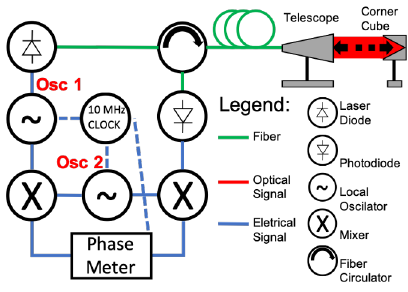
Figure 3. Sensor scheme with Osc 1 at 3 GHz +  f and Osc 2 at 3